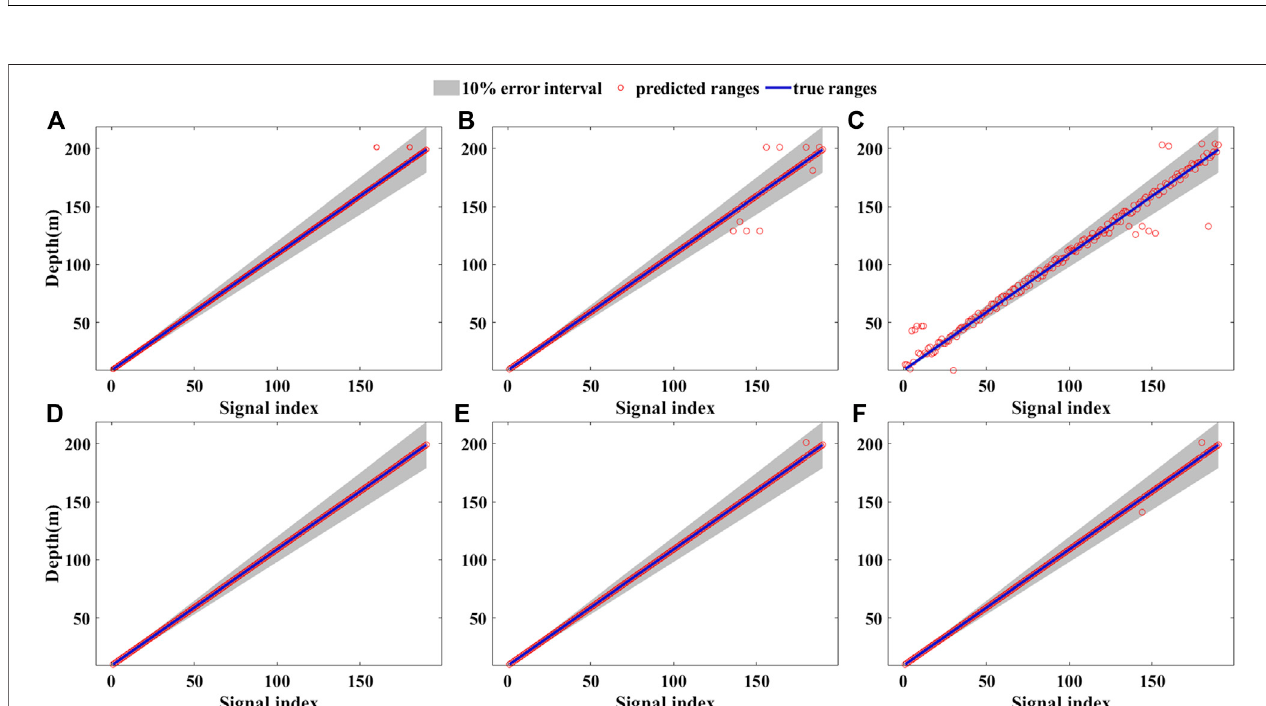
FIGURE4| Depth localizationresults withvarious SNRs byK-ELM. (Top) Thenarrowbandcaseof148 Hz. (Bottom) Thebroadband caseof{4994,235}Hz with SNR of (A) (D) 5 dB, (B) (E) 0 dB, and (C) (F) -5 dB.